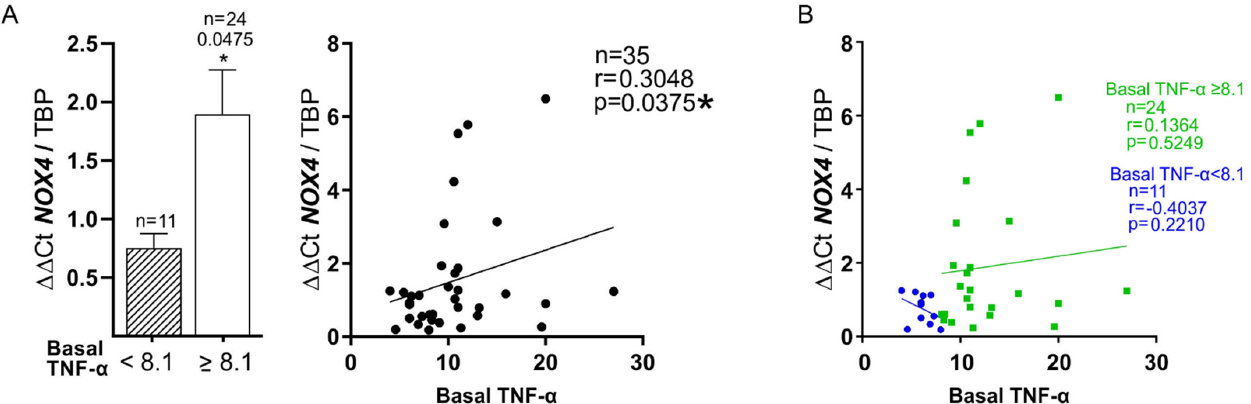
Figure 4. Relationship between high levels of plasma TNF- α ( ≥ 8.1 pg/mL) and NOX4 expression in all patients of the study . ( A ). Left: expression of muscle NOX4 mRNA in relation to plasma TNF- α . Striped bar: TNF- α < 8.1 pg/mL. White bar: TNF- α ≥ 8.1 pg/mL. Right: Spearman correlation between both markers. ( B ). Trend of this correlation differentiating by TNF- α values: ≥ 8.1 (green color) and <8.1 (blue color). * p < 0.05.